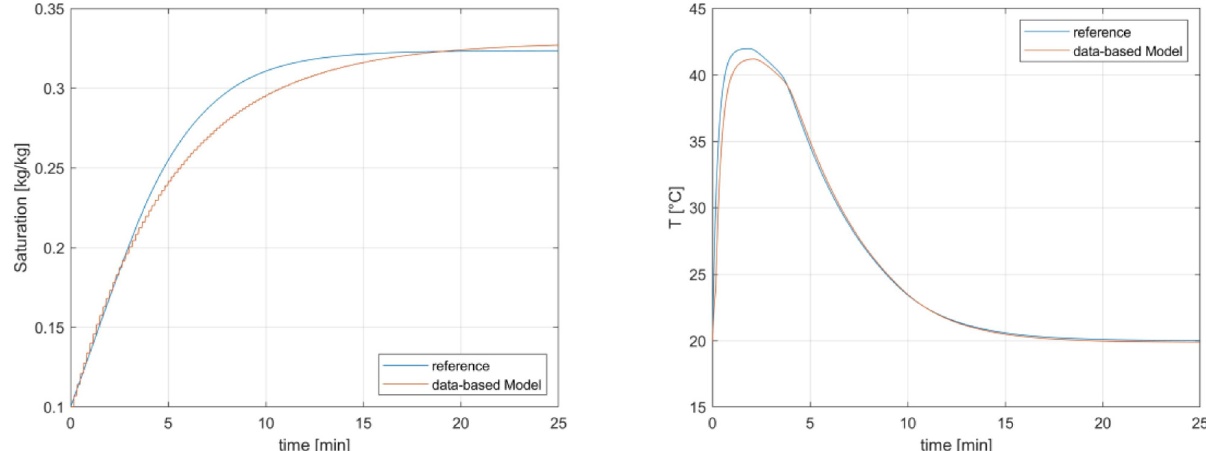
Fig. 8. Comparison between data-based model and simulation data as reference: zeolite saturation x s (left) and out fl ow air temperature T OUT